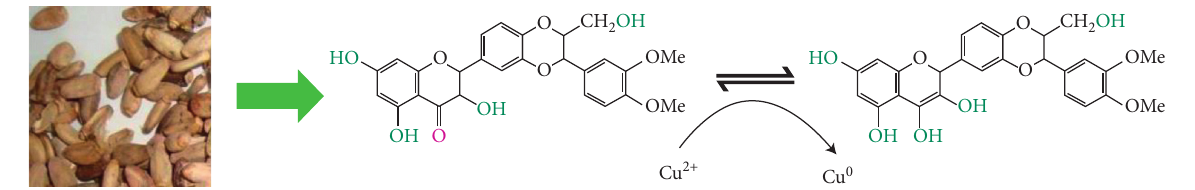
Figure 3: Mechanism of CuNP synthesis using Silybum marianum L. seed extracts [84]. Table 3: Representative examples for the use of plant extracts for CuNP